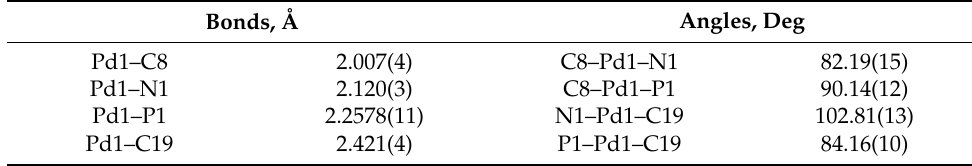
Figure 6. Molecular structure of 5 . Noncoordinated mesylate anion is now shown. Thermal ellipsoids are shown at 0.15 probability level. H atoms are omitted for clarity. Isopropoxy substituents in RuPhos are shown in wireframe style for clarity. Table 4. Selected bond length and angles in 5